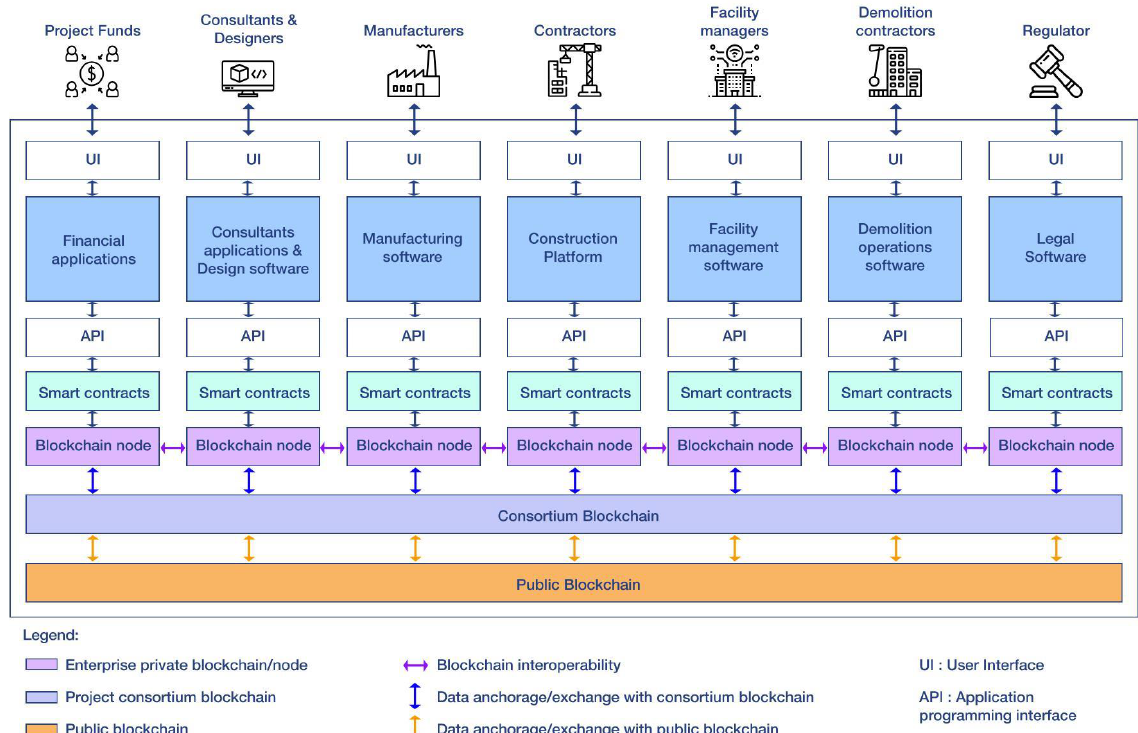
Figure 1. Blockchain ecosystem diagram between industry stakeholders at different levels: enterprise, consortium, and public. Adapted from Figure 10 of the World Economic Forum. Inclusive Deployment of Blockchain for Supply Chains: Part 6—A framework for Blockchain Interoperability; 2020